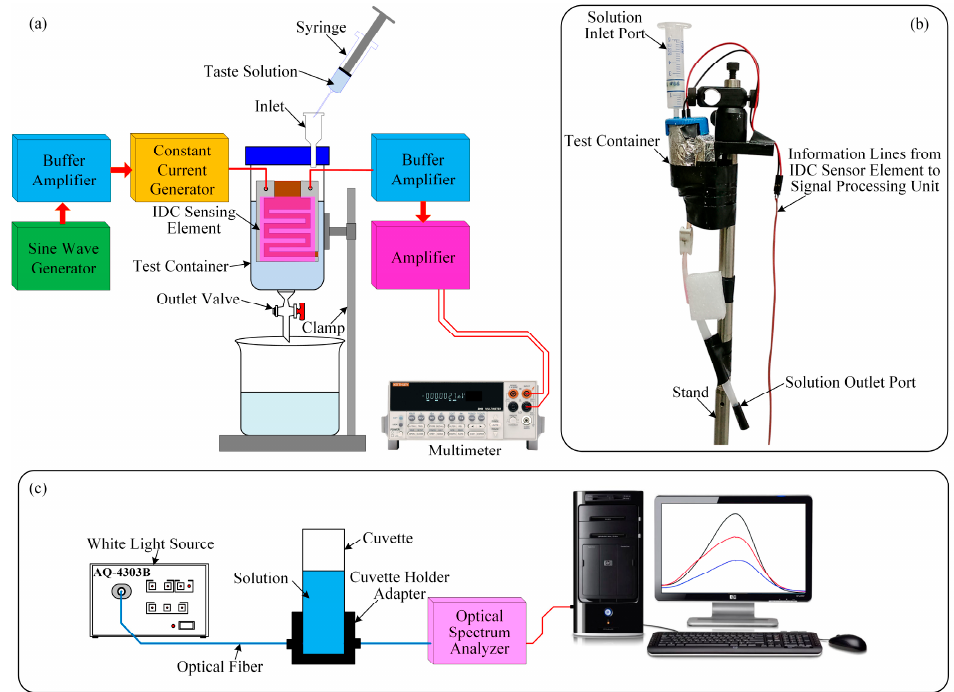
Figure 4. Experimental setup: ( a ) schematic diagram of the IDC glucose biosening system; ( b ) photograph of the various parts of the proposed IDC biosensing system; and ( c ) schematic diagram for measuring the optical properties of different sensing solution under different concentrations of glucose solution.